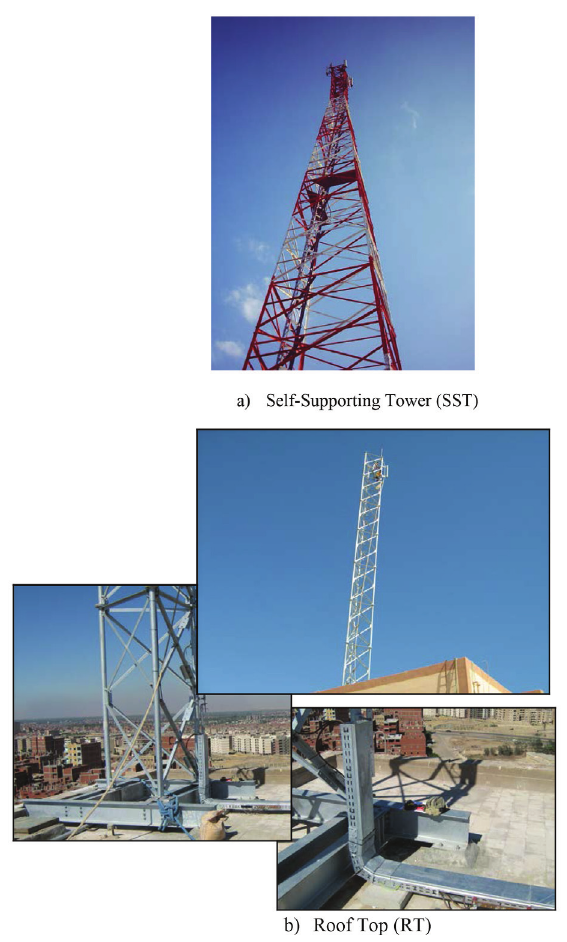
Fig. 1. Structure types of telecommunication